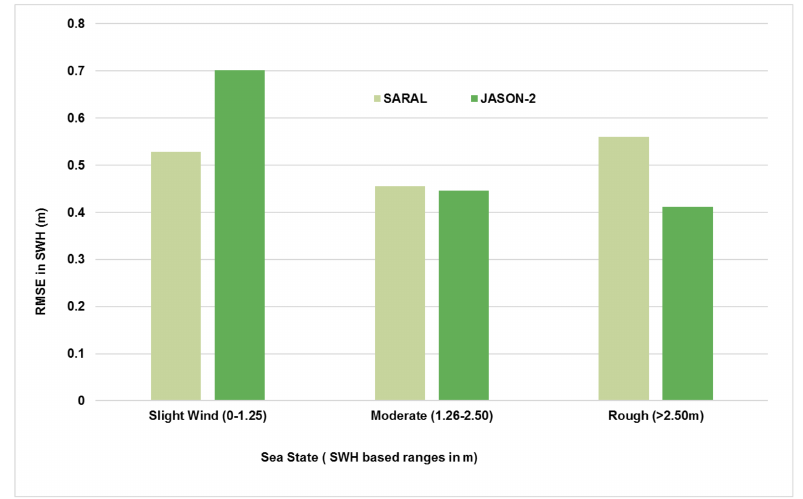
Figure 13. RMSE of SARAL/AltiKa and Jason-2 SWH with respect to buoy observed wave in various sea state categorized on basis of